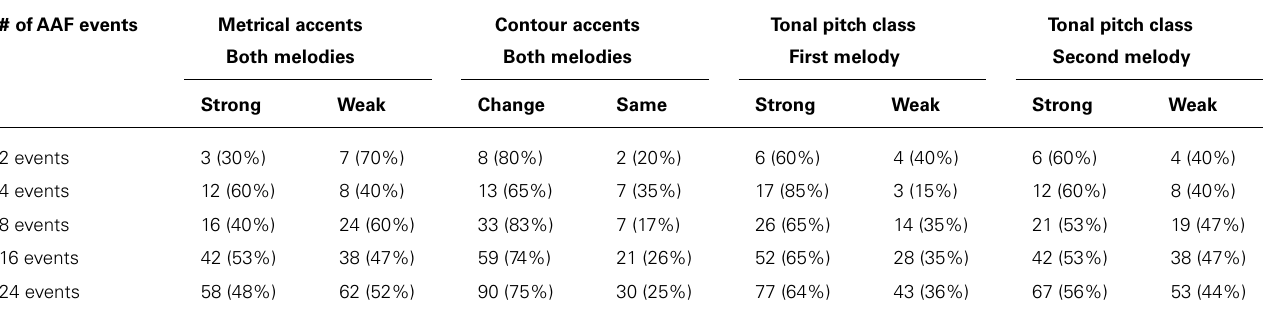
Table 1 | Frequency of altered events at sequence positions associated with different categories of metrical accent, contour accent, and tonal pitch class. # ofAAF events Metrical accents Contour accents Tonal pitch class Both melodies Both melodies Strong Weak Change Same Strong